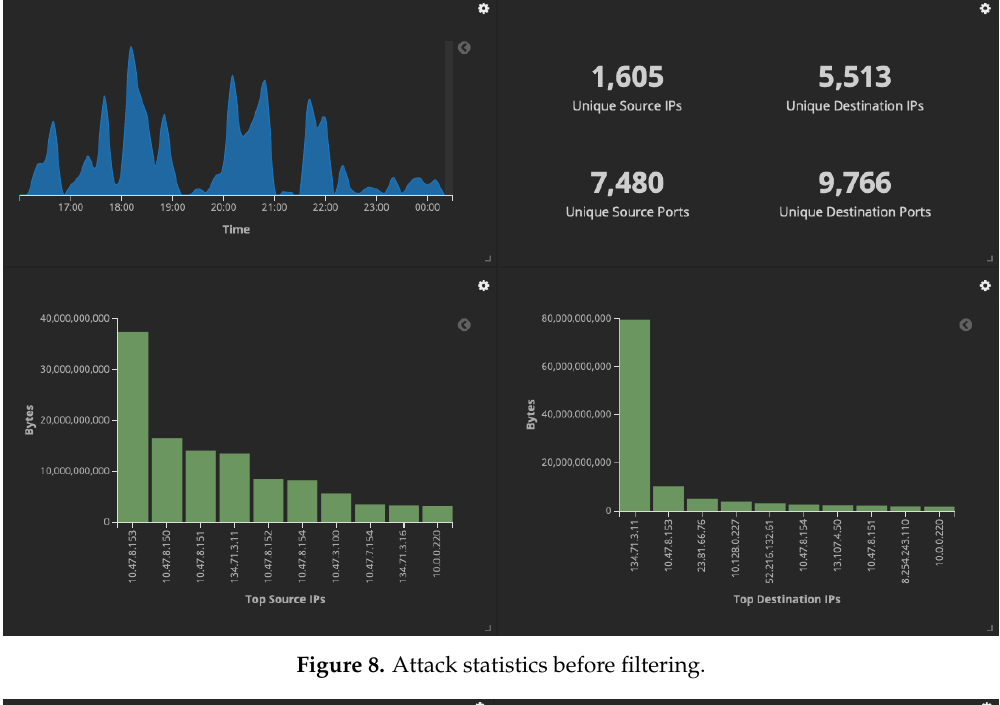
Figure 8. Attack statistics before filtering.